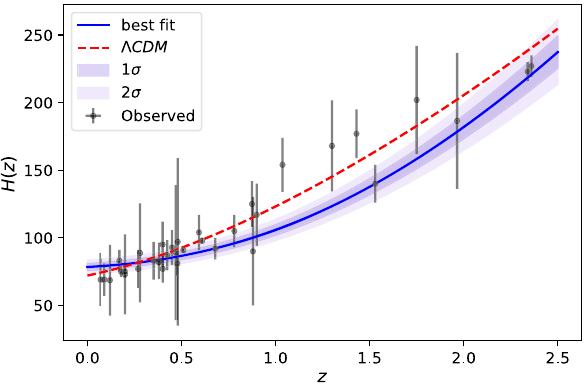
Fig. 7 Plot of the reconstructed Hubble parameter H ( z ) for Model I I I , Higgs Potential. The best fit values and the associated 1 σ , 2 σ confidence regions are obtained from the combined analysis